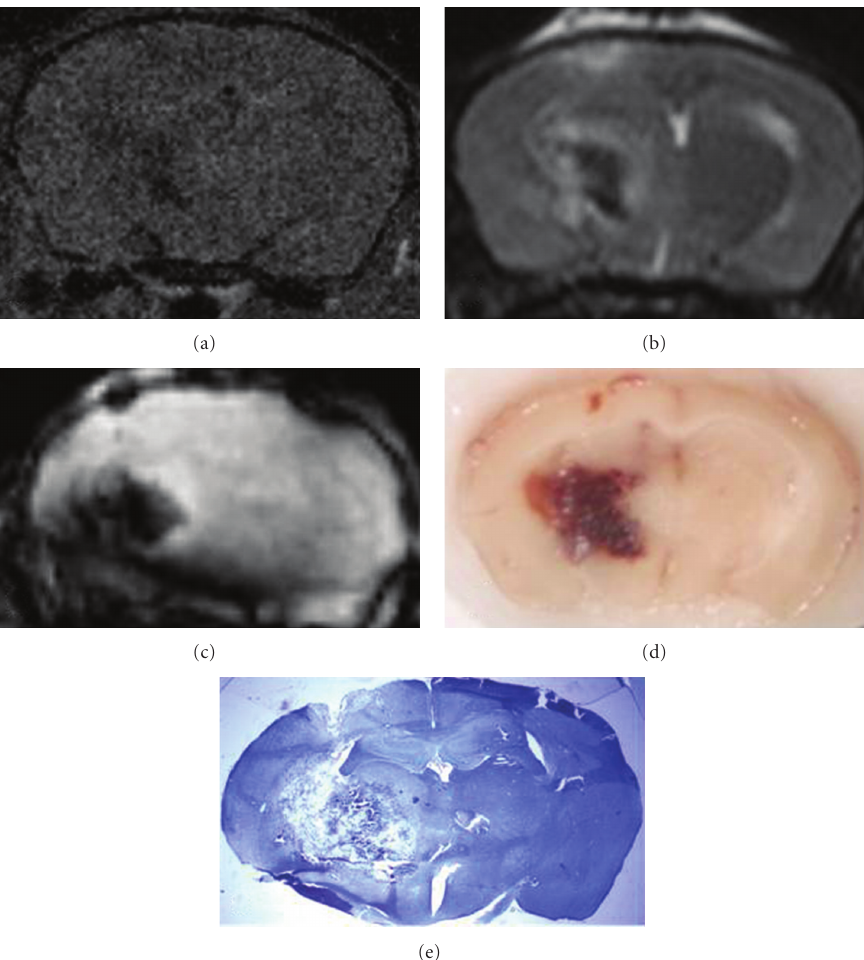
Figure 2: T1- (a), T2- (b), and T2 ∗ - (c) weighted images in a mouse 24 hours after hematoma induction reveal a hypointensity that matched well with the hematoma size found on frozen section (d) and cryostat section stained with Luxol Fast Blue and cresyl violet [ × 10] (e). Again, T2 ∗ -weighted images need referencing with T1- and T2-weighted images for hematoma quantitation. Of note is an artefact on the left to midventral surface (c).